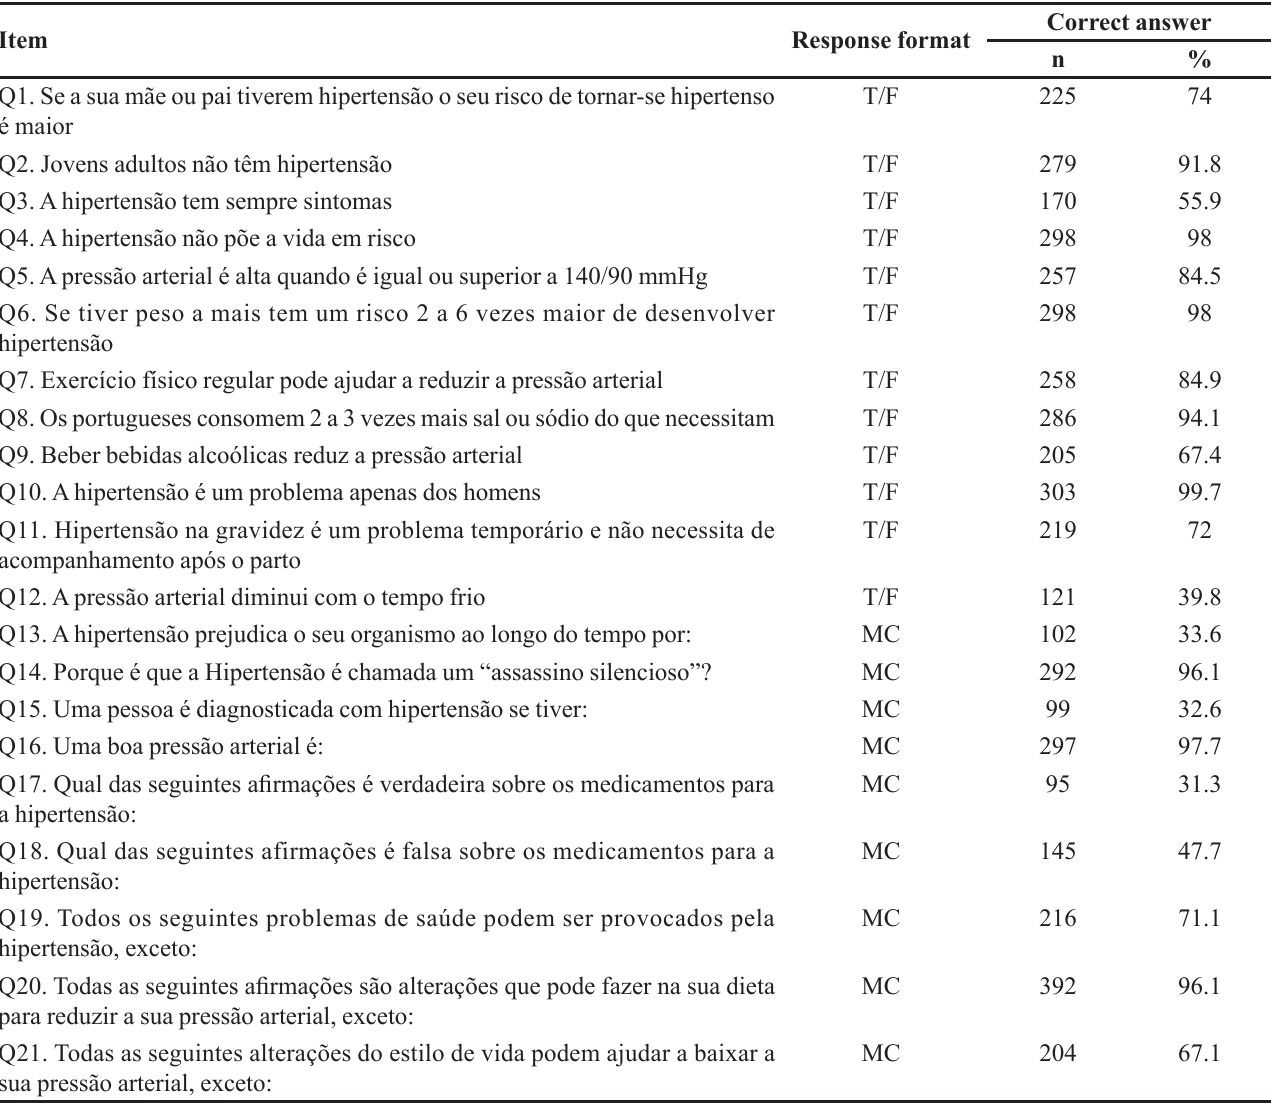
TABLE I - Proportion of correct answers on the Hypertension Knowledge Test (n=304)